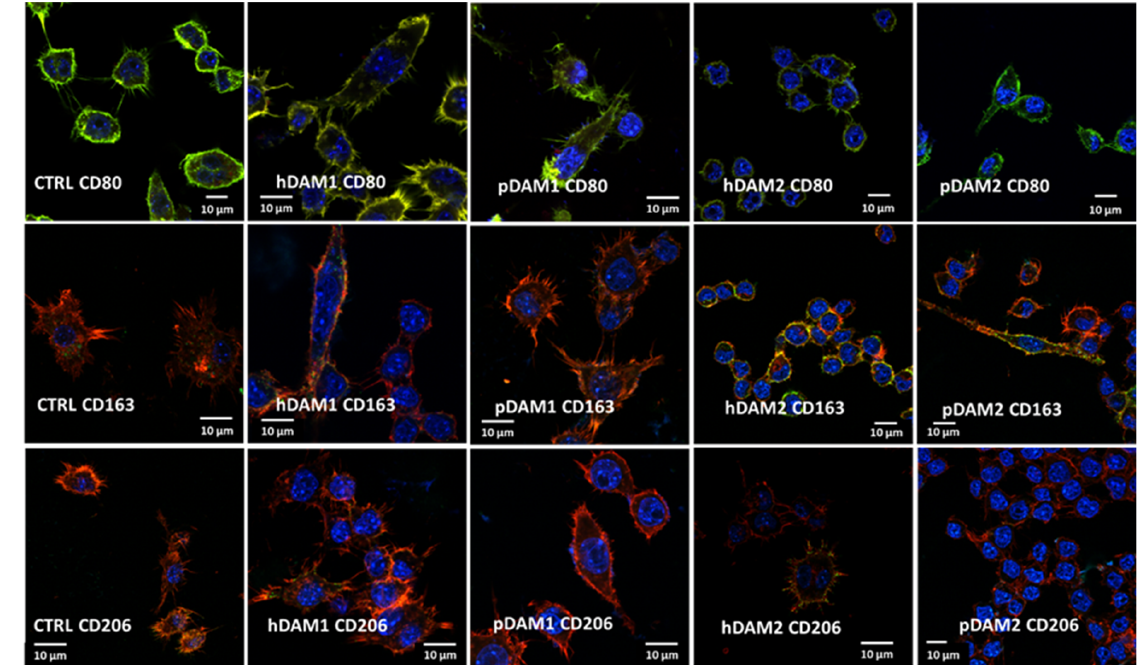
Figure 3. M1 and M2 specific markers observed by confocal microscopy in RAW-264.7 macrophages after 24 h of culture on control surface (CTRL) and human or porcine DAMs obtained by the enzymatic method (hDAM1and pDAM1) and organic solvents treatment (hDAM2 and pDAM2). Top panel: CD80 in red, cytoskeleton actin filaments in green (colocalization results in yellow coloration) and nuclei in blue. Middle and lower panels: CD163 and CD206 are observed in green, cytoskeleton actin filaments in red (colocalization results in yellow coloration), and nuclei in blue.